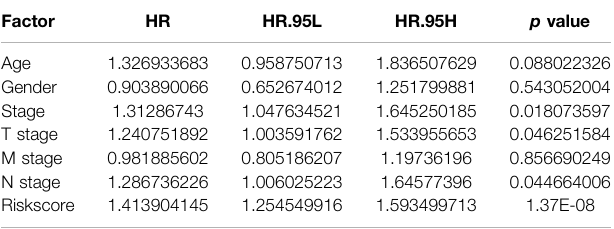
TABLE 5 | Prognosis-related clinicopathological features of LUAD patients were shown via the multivariate Cox regression analysis. Factor